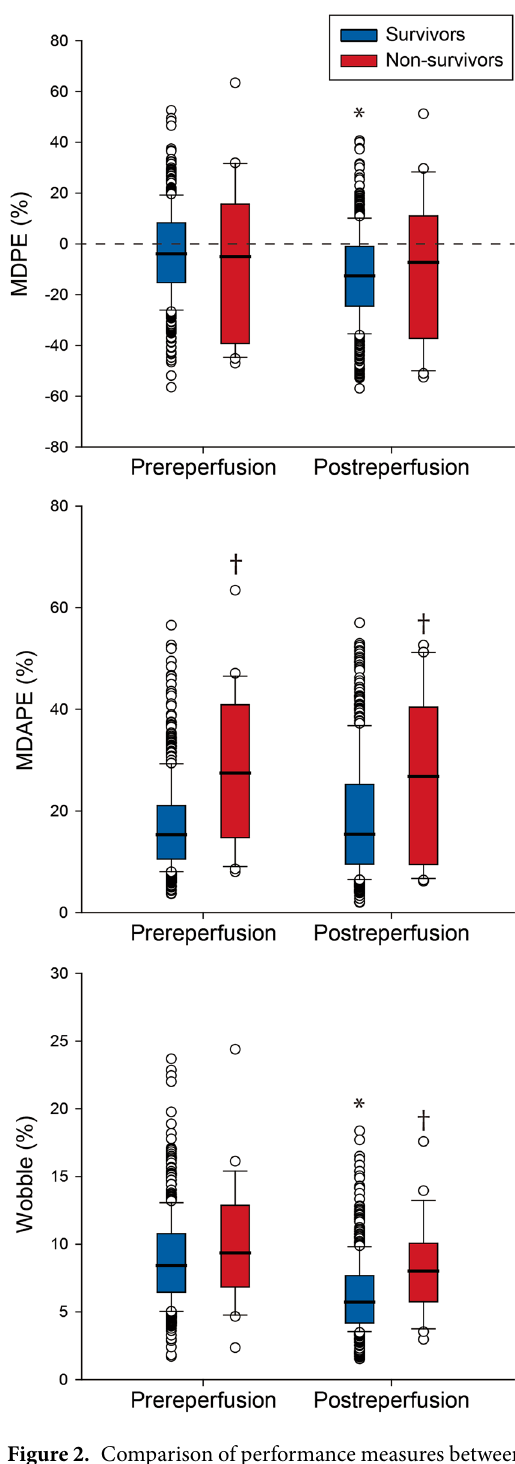
Figure 2. Comparison of performance measures between survivors and non-survivors. Box plot shows median and interquartile range of prereperfusion and postreperfusion MDPE, MDAPE, and wobble in survivors and non-survivors. Upper and lower whiskers are maximum and minimum values, respectively. Round symbols show the 5th/95th percentile values. Prereperfusion and postreperfusion MDPE were similar between groups. However, prereperfusion and postreperfusion MDAPE, and postreperfusion wobble were significantly larger in non-survivors compared to survivors. * P < 0.001 vs prereperfusion values, † P < 0.001 vs survivors. Abbreviations: MDPE = median performance error, MDAPE = median absolute performance